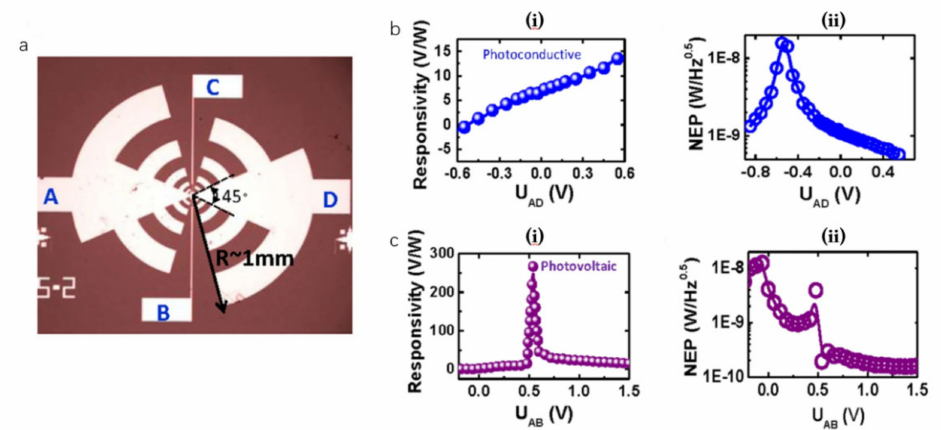
Figure 9. ( a ) The electrical configuration of the device, and changing the connections of the four terminals switch modes, ( b ) The responsivity and NEP curve in photoconductive mode. ( c ) The responsivity and NEP curve in photovoltaic mode. Reprinted with permission from ref.